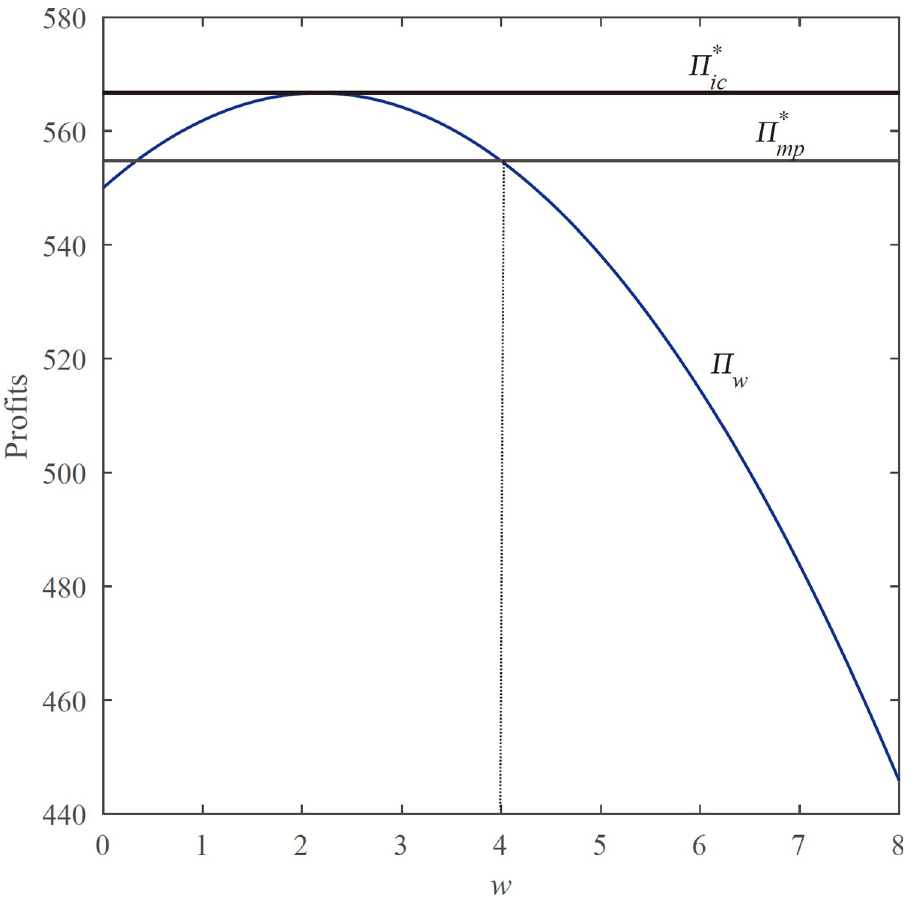
Fig 3. Comparison of the profits function with respect to w . Demand follows a uniform distribution U [0,100], and parameter values are p s = 15 , p o = 11 , c o = 5 , c s = 4 , θ = 0.5 , h o = 3 , and h s = 1